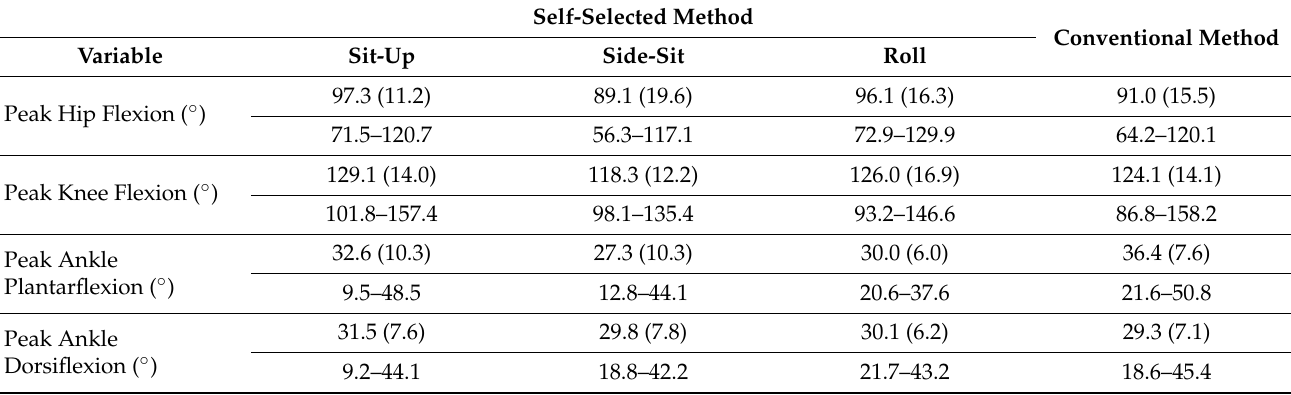
Table 3. Mean ( ± SD) and range data are presented for the peak sagittal kinematic angles at the hip, knee and ankle joints for each of the methods of the floor to stand